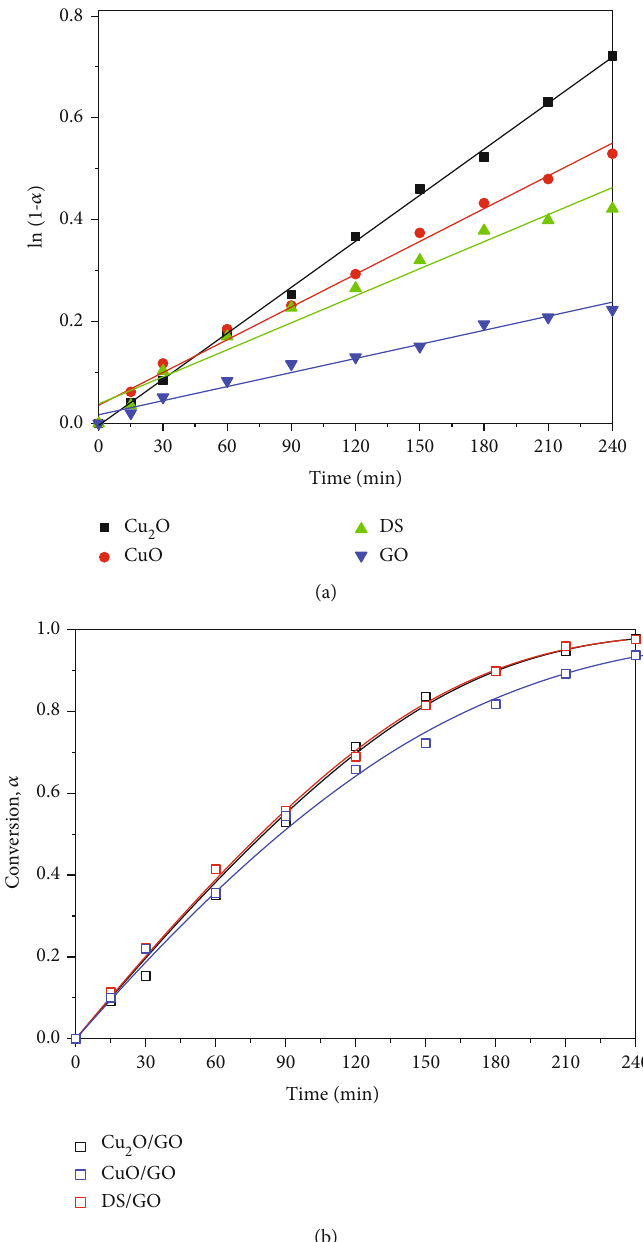
Figure 4: (a) ln ð 1 − α Þ vs. time for unsupported catalysts and GO systems. (b) Conversion vs. time plots for three supported catalyst